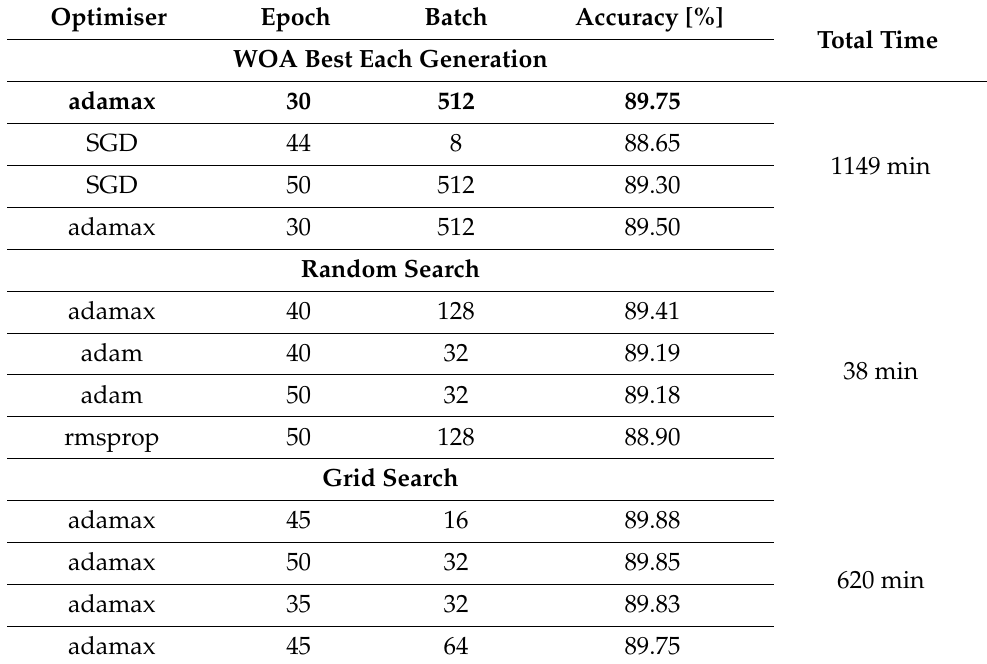
Table 5. Fashion MNIST 3D search space, epoch (0–50), discrete optimiser, discrete batch.